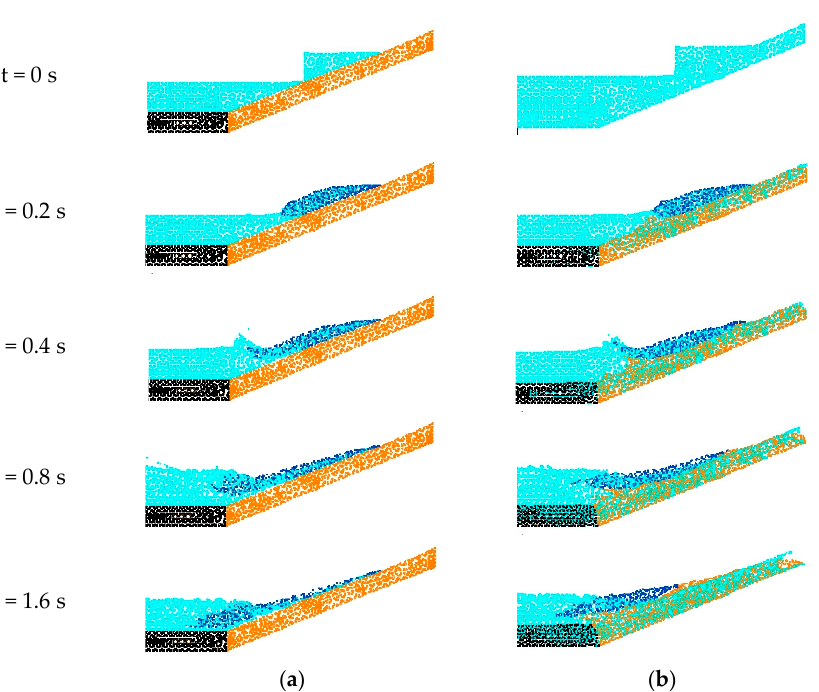
Figure 17. Snapshots of the landslide process of saturated particles at different moments on ( a ) rigid slopes; and ( b ) erodible slopes.